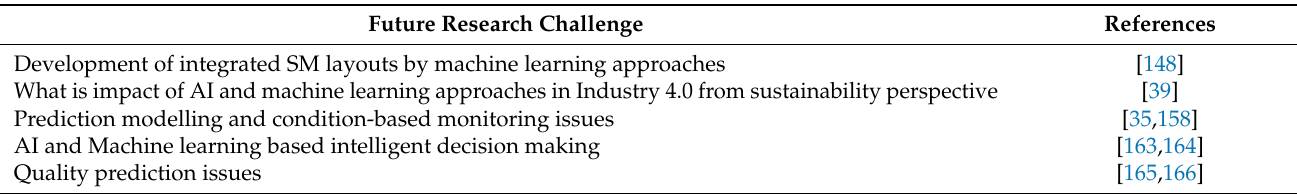
Table 7. Research issues in artificial intelligence (AI) and machine learning-enabled practices for manufacturing sustainability. Future Research